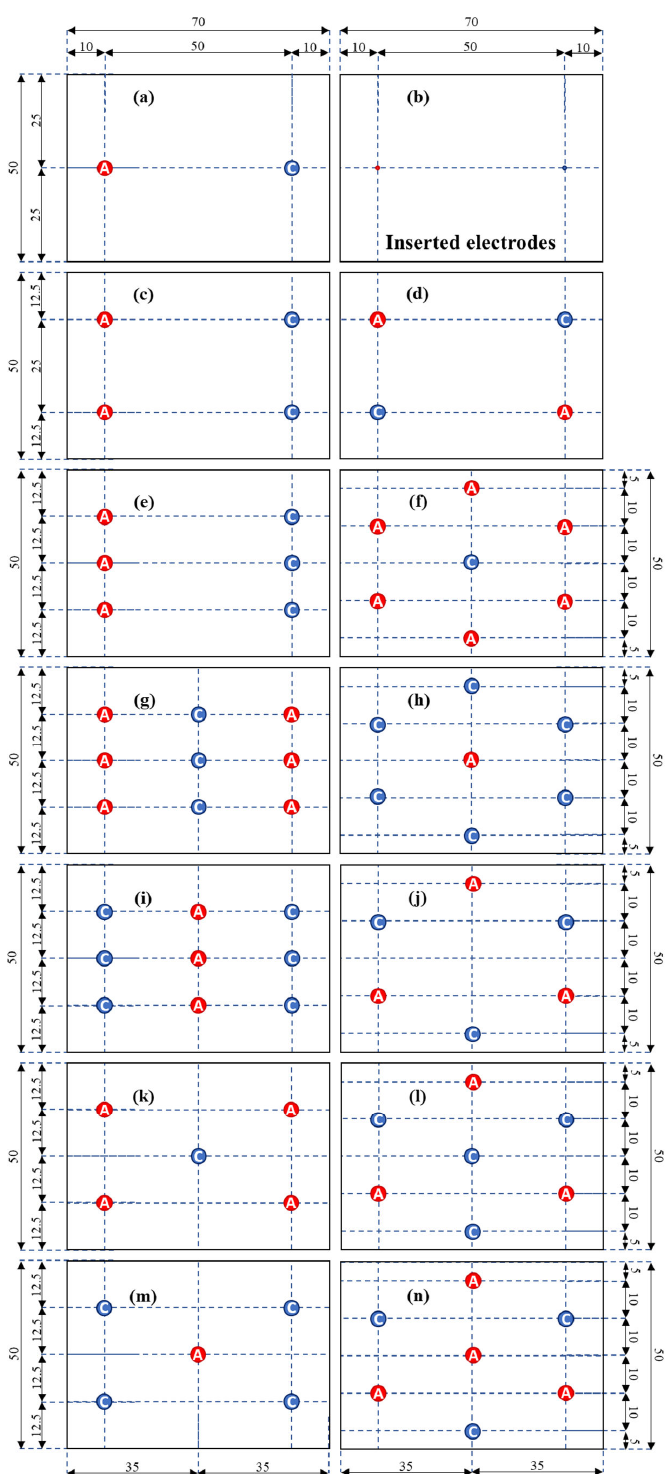
Figure 1. Schemes of the simulated electrode configurations. ( a ) opposed electrodes in electrolyte reservoirs; ( b ) opposed electrodes inserted into the soil; ( c – n ) alternative distributions of electrodes inserted in electrolyte reservoirs. A in red is for anode(s) and C in blue is for cathode(s). The hydraulic initial condition is given by the initial value of the state variable of the water mass balance equation: the liquid pressure. The initial water content, the void